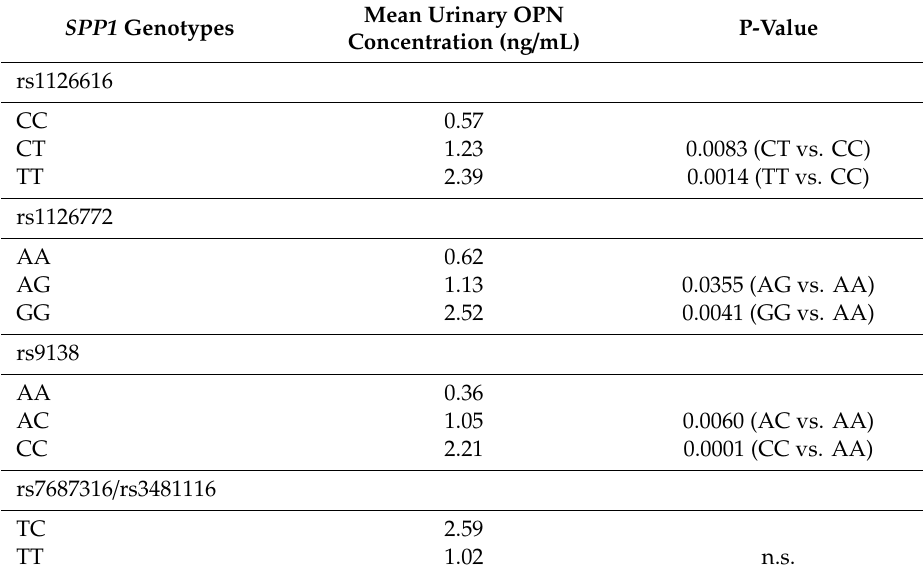
Table 3. Association of SPP1 polymorphisms and urinary OPN excretion in IgAN patients. Mean Urinary OPN SPP1 SPP1 Genotypes